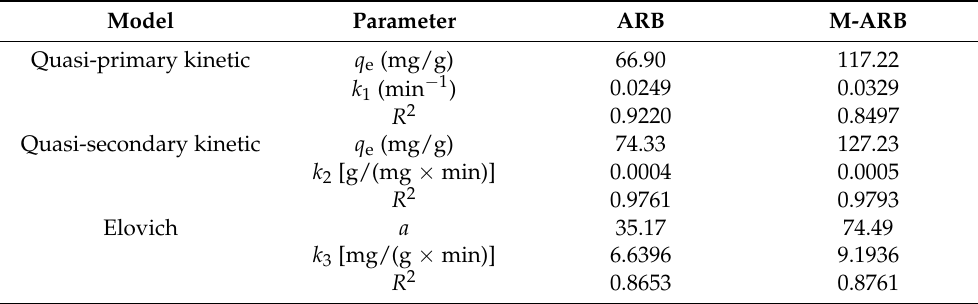
Table 2. Adsorption kinetics fitting parameters of MB onto ARB and M-ARB.